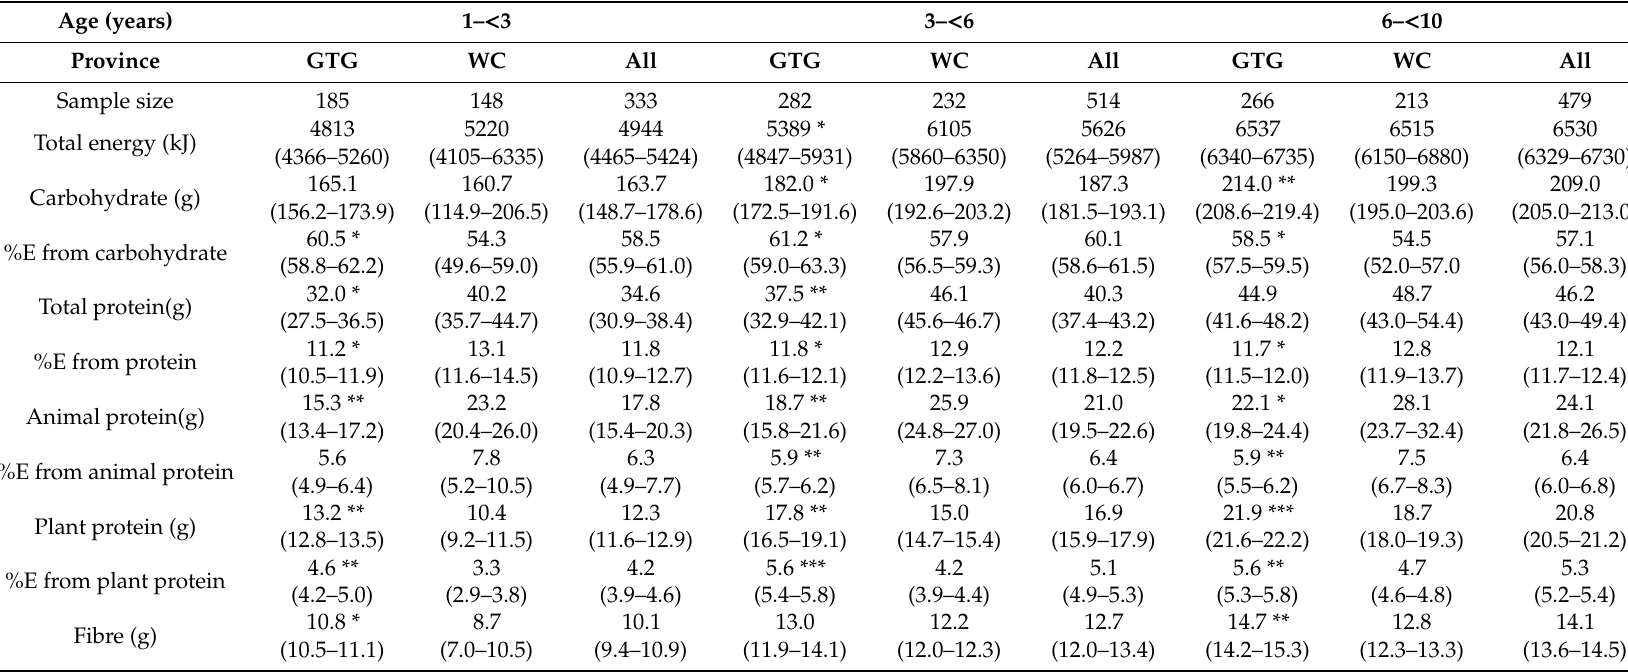
Table 3. The mean energy (95%CI), carbohydrate, protein, and fibre intake of children aged 1– < 10-years by age and province (N =